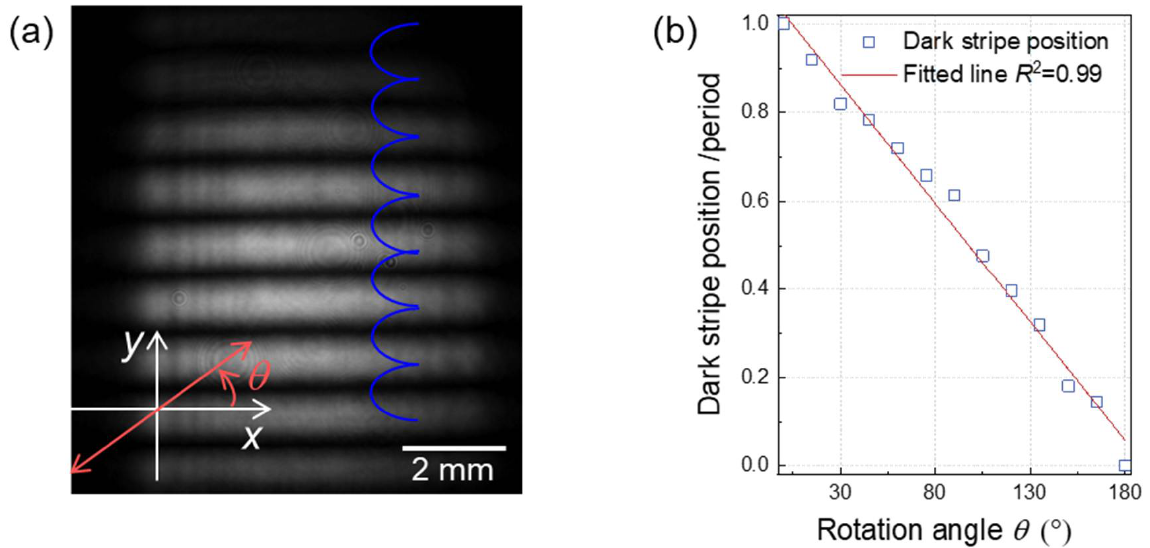
Figure 2. ( a ) Cross-sectional intensity distribution of the femtosecond vector beam recorded by the CCD camera in the dashed frame shown in Figure 1. The transmission axis of the linear polarizer (LP2) is indicated by the double-ended arrow, whose orientation is denoted by the angle θ . θ = 0 in the recording of this picture. The blue solid curve shows the polarization distribution of the laser beam. ( b ) Dependence of the dark stripe’s position in ( a ) on the rotation angle θ of the linear polarizer (LP2).